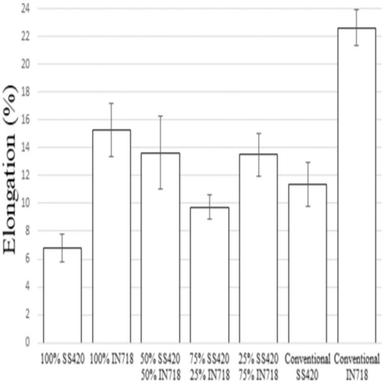
Ductility (% elongation) measurement of the tensile coupons of laser-DED and conventionally fabricated samples.